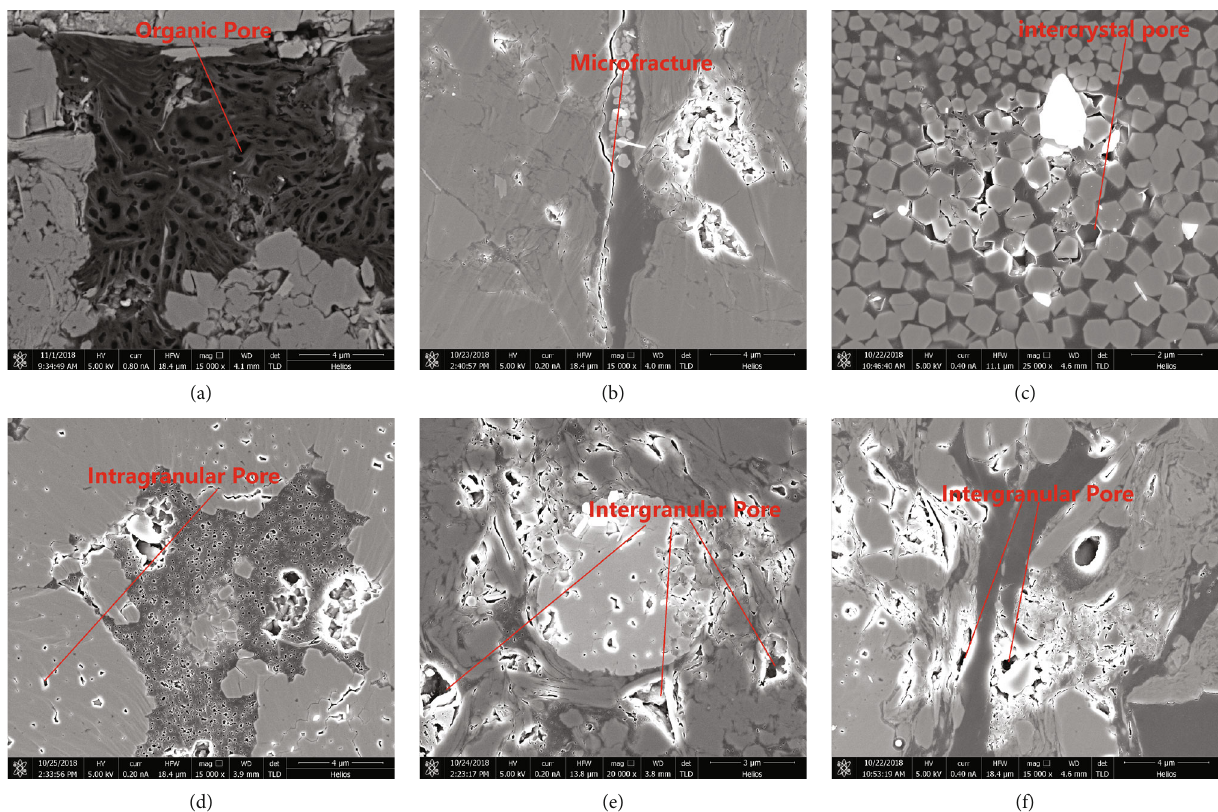
Figure 12: Images showing the pore characteristics of LF shale in well L1; (a) well L1, organic matter-hosted pore, LWF, 1057.97m; (b) well L1, micro fi ssure, LWF, 1069.38m; (c) well L1, intercrystal pore, LWF, 1081.67m; (d) well L1, intragranular pore, LWF, 1063.05m; (e) well L1, intergranular pore, LWF, 1075.33m; (f) well L1, intergranular pore,